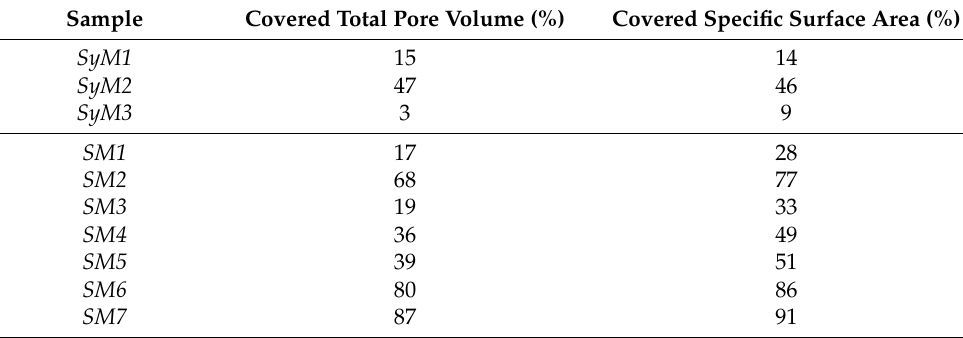
Table 3. Pore coverages of MTZ immobilized on the mesoporous silica materials.